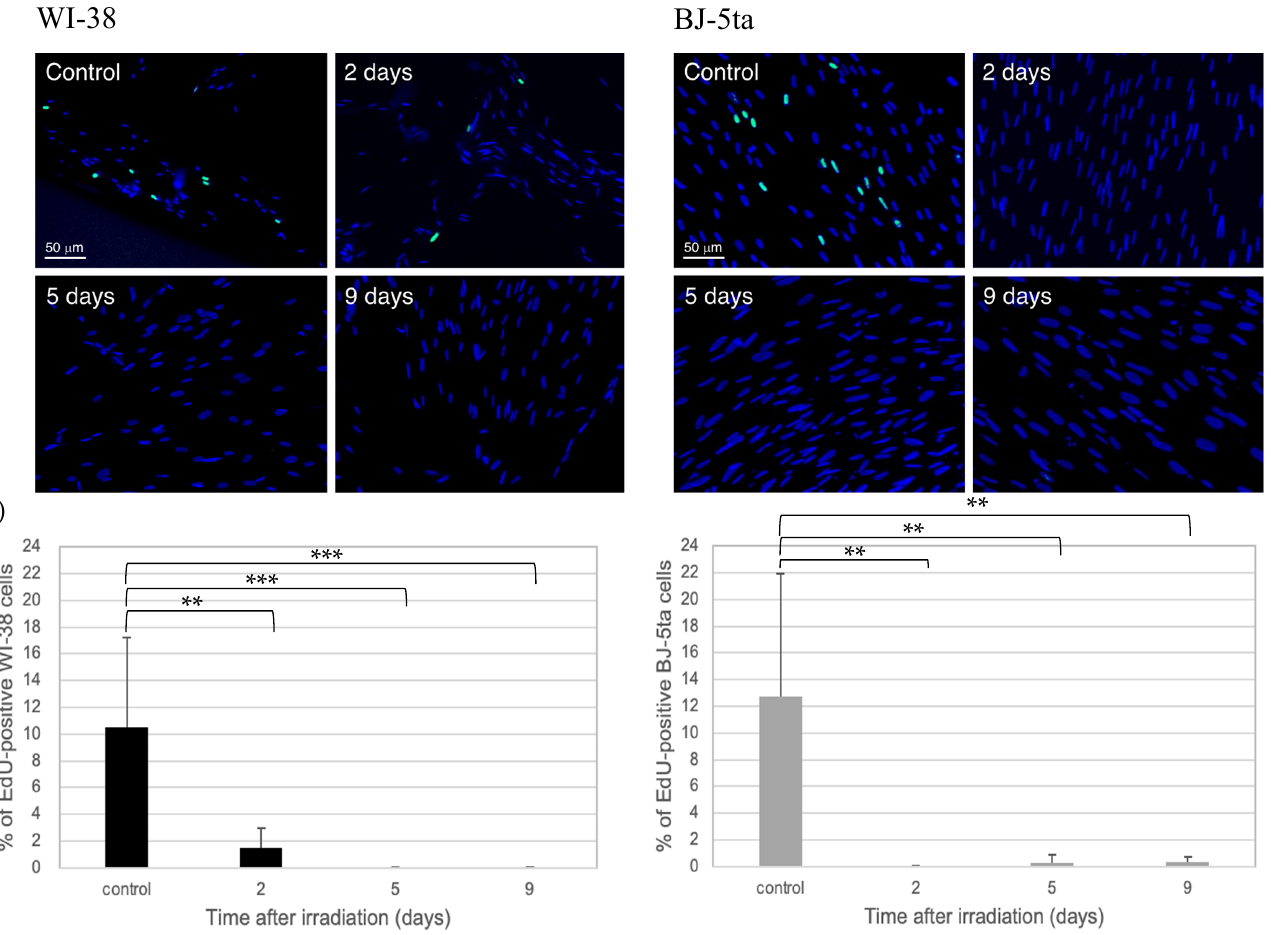
Figure 2. ( A ) Representative microscopic images of EdU–and DAPI-stained cells. Nonirradiated (control) and 20 Gy X-irradiated WI-38 and BJ-5ta cells observed under a fluorescence microscope at 20 × magnification. The images of the irradiated cells were taken at 2, 5, and 9 days after irradiation. EdU was added for 2 h before analysis. A significant decrease in the percentage of EdU-positive green cells indicates that irreversible cell-cycle arrest has occurred. The cells were counterstained with DAPI (blue). The scale bar was common for the images of each cell. ( B ) Quantification of cell proliferation based on EdU uptake in nonirradiated (control) and irradiated WI-38 and BJ-5ta cells. The number of EdU-positive WI-38 and BJ-5ta cells divided by the total number of cells in three microscopic fields are plotted against the incubation time. Approximately 200 cells were scored in one microscopic field. The error bars represent the standard deviation. Statistical analysis was performed with one-way ANOVA ( p < 0.001) plus a Student’s t-test. The symbol * indicates the p -values of the t -test compared with the control and irradiated samples, respectively; *** p < 0.001 and ** p < 0.01.